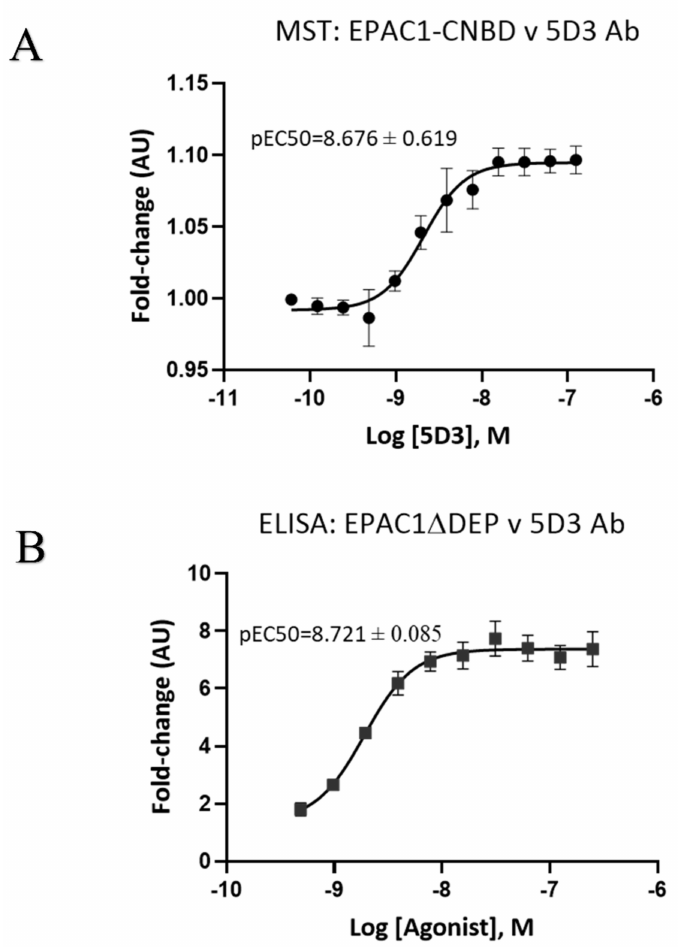
Figure 4. Relative binding affinities of anti-EPAC1 antibody (mAb 5D3) to recombinant EPAC1-CNBD or EPAC1 ∆ DEP using microscale thermophoresis (MST) and ELISA. ( A ) Recombinant